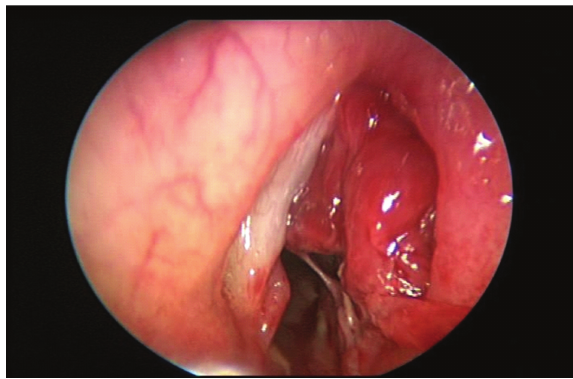
Figure 1: Endoscopic view of the right laryngopyocele before marsupialisation and excision.